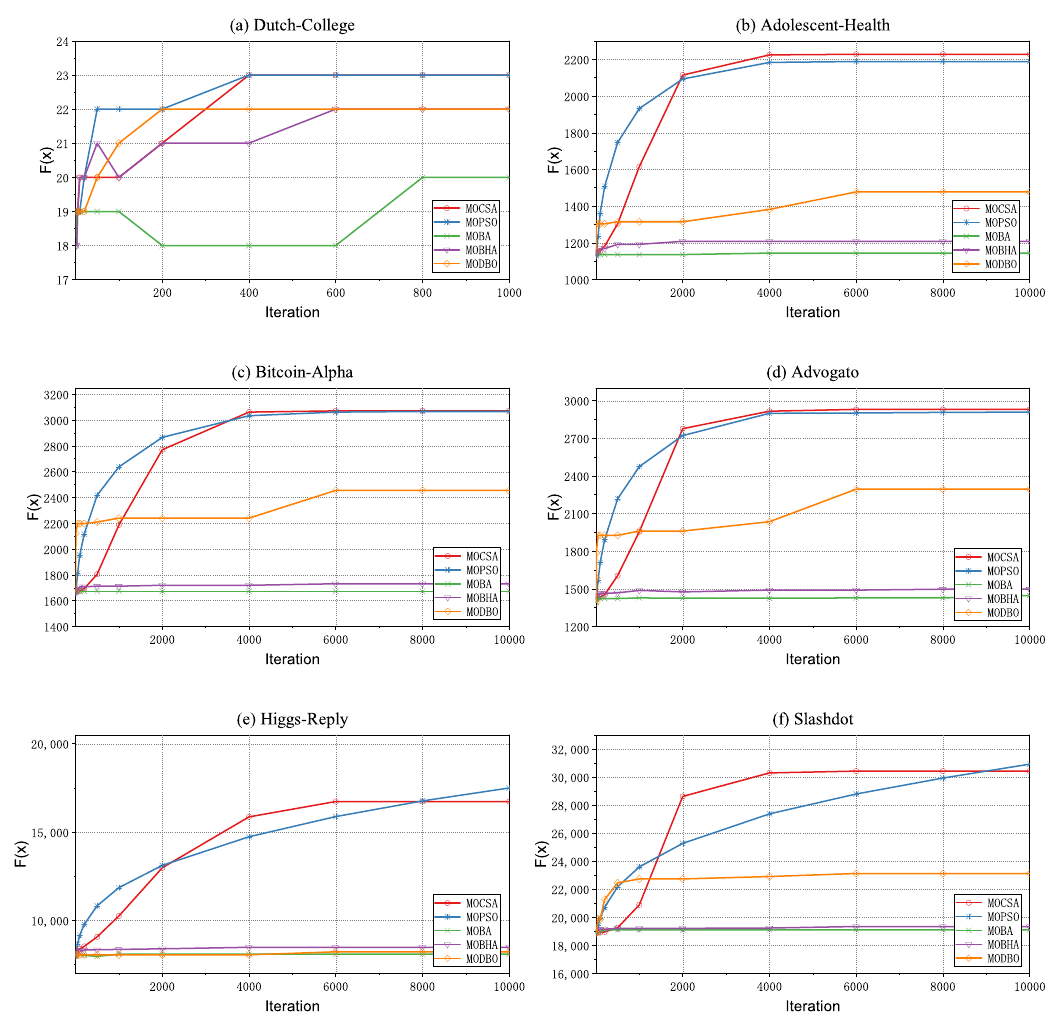
Figure 6. Comparison on fitness of different algorithms on six real social networks. The approximated Pareto Frontiers obtained using different algorithms on the six real social networks are shown in Figure 7. Compared to other solutions, the solutions in MOBA and MOBHA are relatively dense. On the contrary, in MODBO, their distribution is sparse, which may be due to its unique search method. Similar to MOPSO, the proposed algorithm MOCSA provides a larger distribution of solutions in the objective search space. It is obvious that the objective function of minimizing seed costs conflicts with the objective of minimizing seed set size. In most cases, the proposed MOCSA algorithm outperforms the benchmark algorithm. Although MOCSA may not produce the best results in any situation; it is competitive in almost all